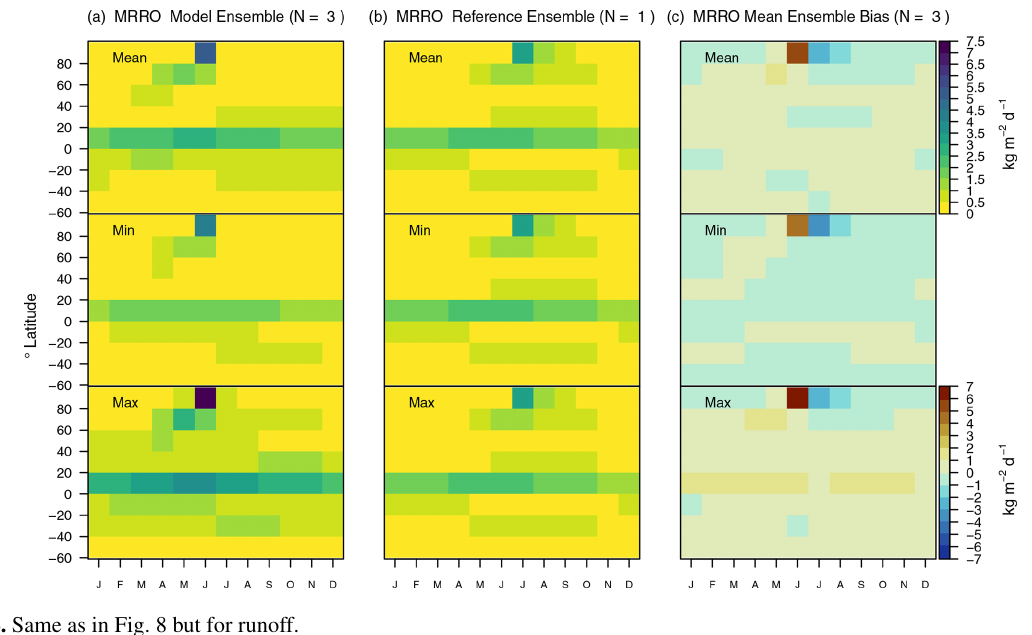
Figure A14. Same as in Fig. 8 but for runoff.